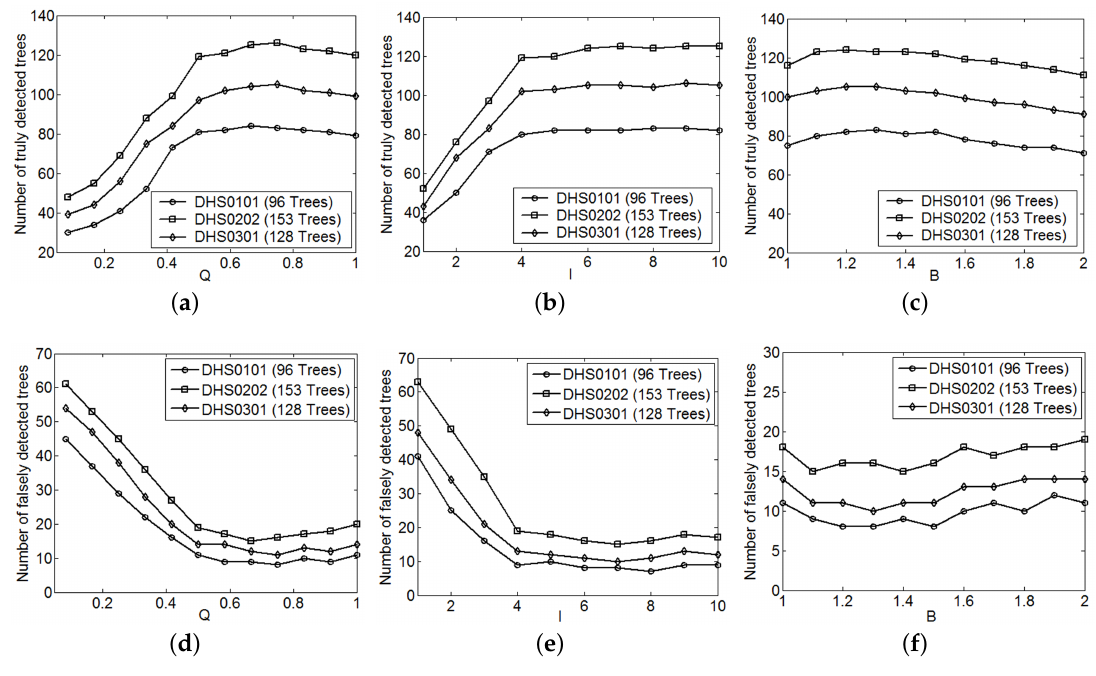
Figure 7. ( a – f ) Sensitivity analysis for three different data sets. ( a , d ) With respect to Q ( I = 6 and B = 1.2). ( b , e ) With respect to I ( Q = 2/3 and B = 1.2). ( c , f ) With respect to B ( Q = 2/3 and I =